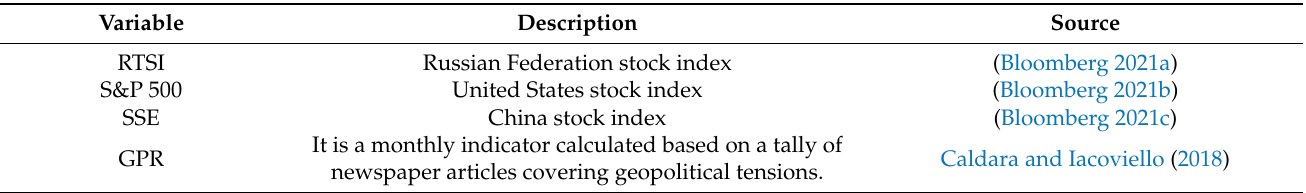
Table 1. Variables